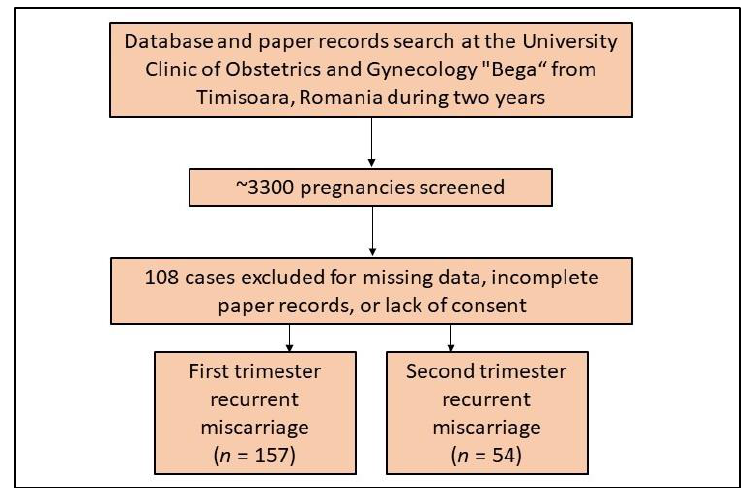
Figure 1. Flowchart displaying cases included in the current study.